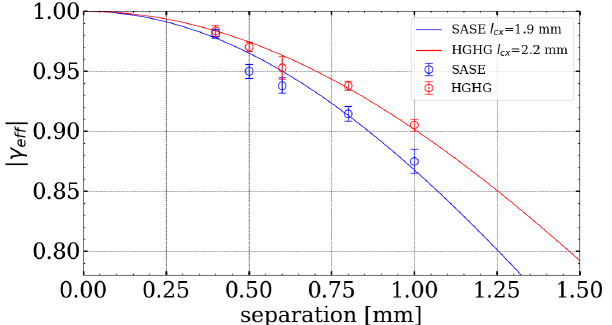
FIG. 5. The degree of transverse coherence γ slit separation, for SASE (blue circles) and HGHG (red circles) and the fit for Gaussian decay HGHG (red) and SASE (blue) solid lines providing the transverse coherence lengths.